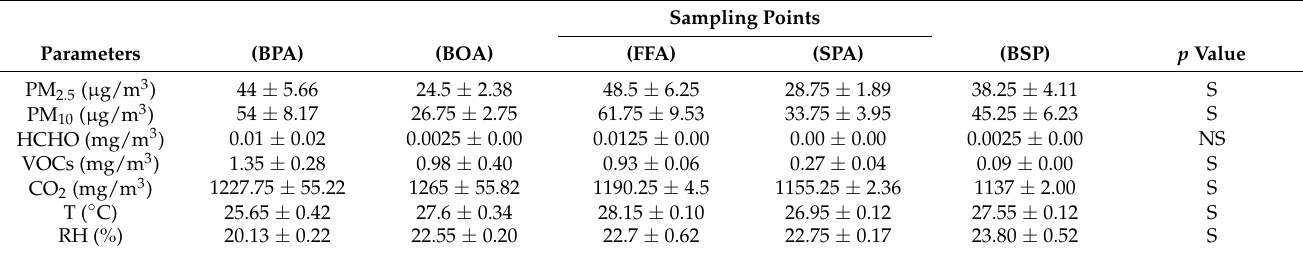
Table 3. Measured Indoor Air Quality at monitored Workstations within